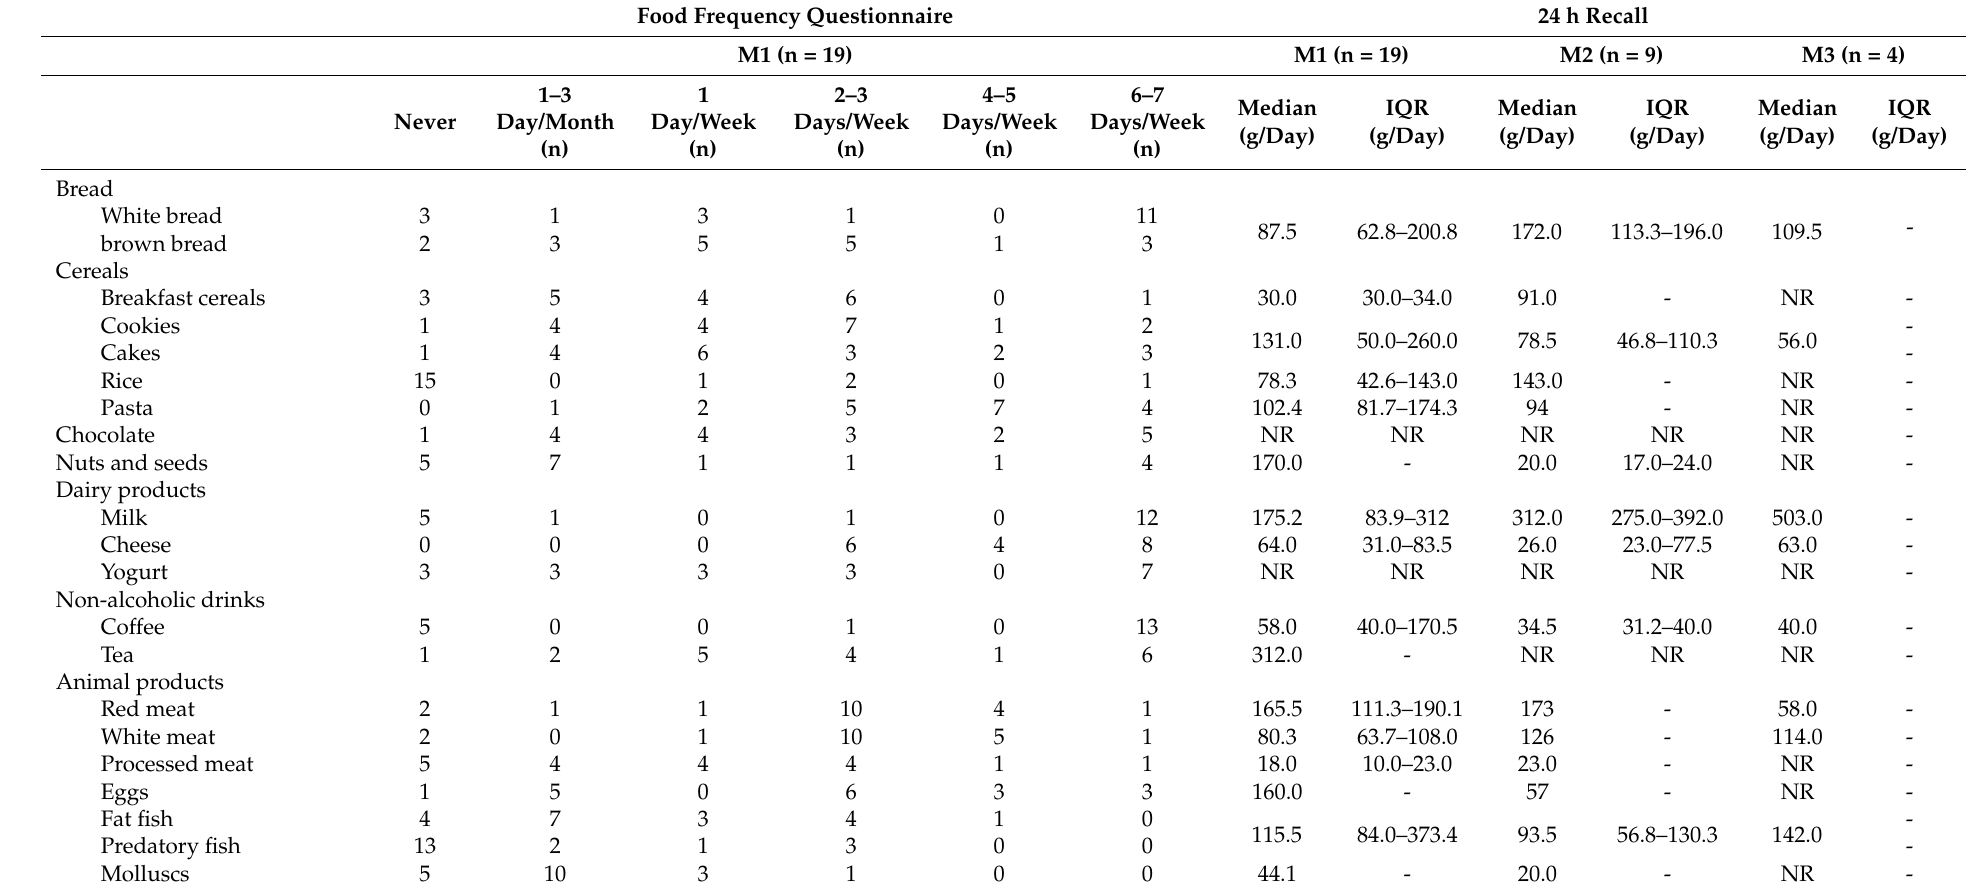
Table 3. Food consumption data obtained through a food frequency questionnaire and 24 h dietary